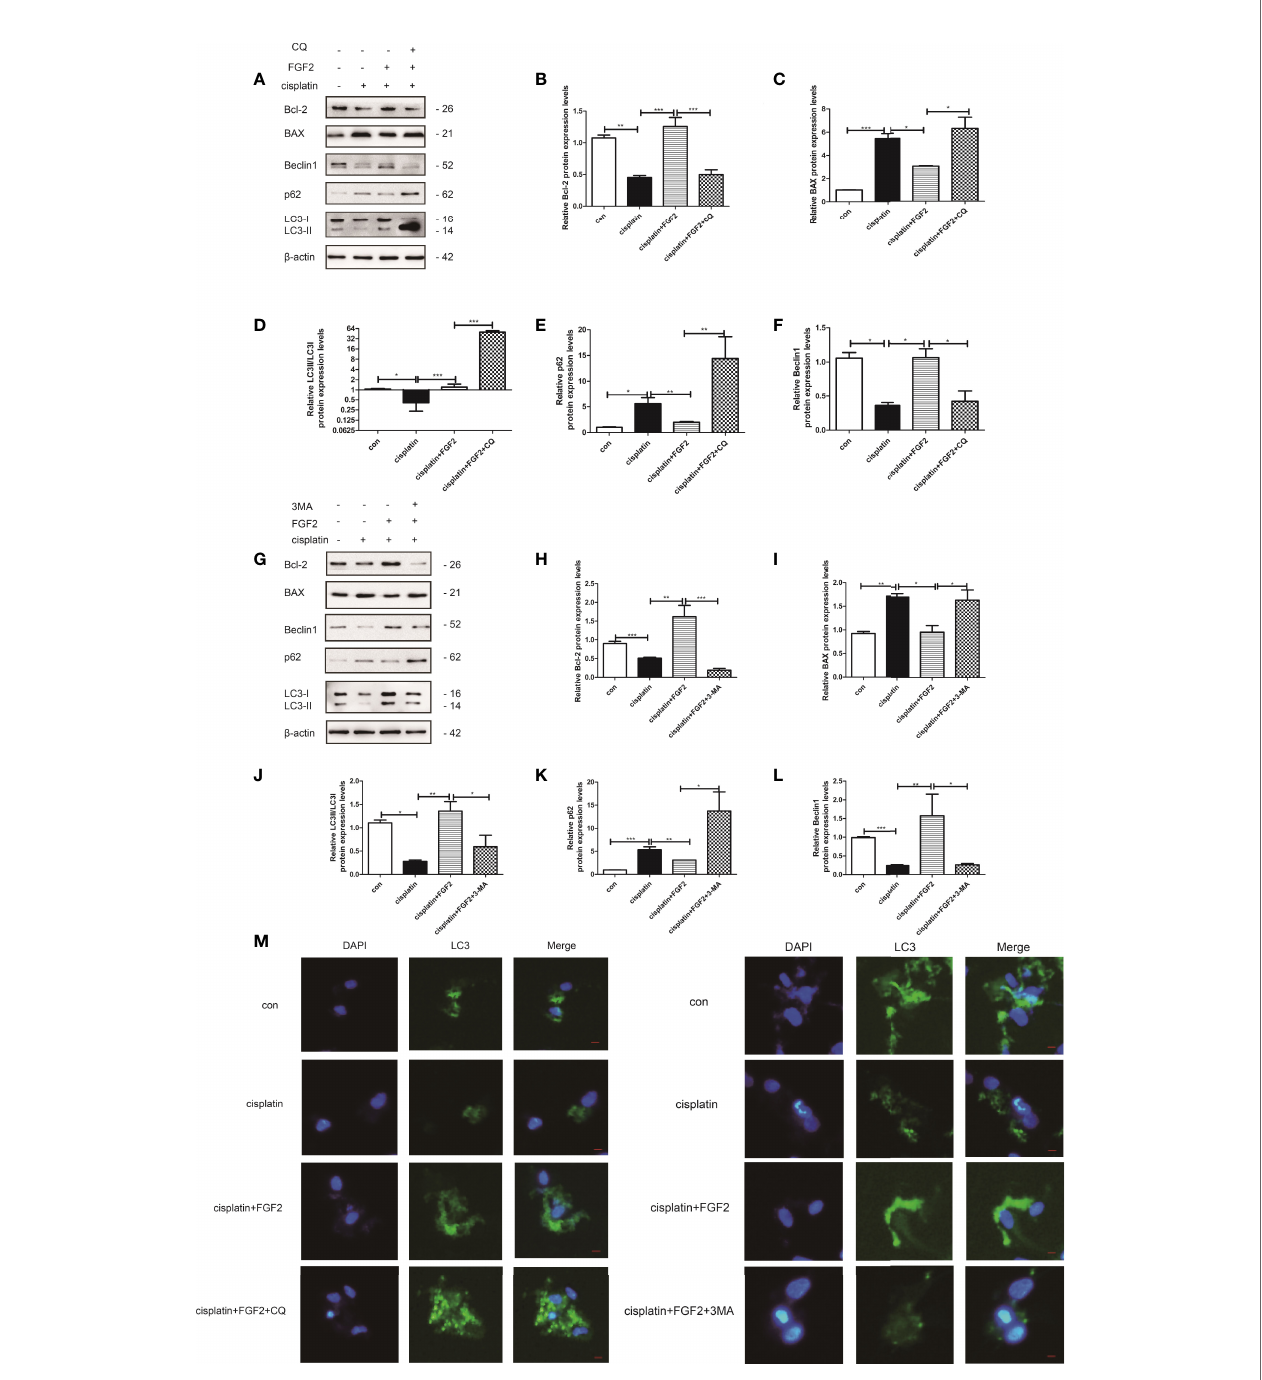
FIGURE 3 | Inhibition of autophagy by 3-MA and CQ attenuated the protective effects of FGF2 on injured KGN cells. (A) The injured KGN cells were treated with FGF2 (25 ng/ml) for 72 h and incubated with 3-MA (10 mM) for another 24 h. The expression of Bcl-2, BAX, LC-3, Beclin1, and p62 was monitored by Western blot. Here, b -actin was used as a loading control. (B – F) Quantitative comparison of the different expression levels of Bcl-2, BAX, LC3, Beclin1, and p62. One-way ANOVA followed by Tukey ’ s multiple comparison test. The results were shown as mean ± SEM from three independent experiments ( a = 0.05, * P < 0.05, ** P < 0.01, *** P < 0.001). (G) The injured KGN cells were treated with FGF2 (25 ng/ml) for 72 h and incubated with CQ (50 m M) for another 24 h. The expression of Bcl-2, BAX, LC-3, Beclin1, and p62 was monitored by Western blot. Here, b -actin was used as a loading control. (H – L) Quantitative comparison of the different expression levels of Bcl-2, BAX, LC3, Beclin1, and p62. One-way ANOVA followed by Tukey ’ s multiple comparison test. The results were shown as mean ± SEM from three independent experiments ( a = 0.05, * P < 0.05, ** P < 0.01, *** P < 0.001). (M) Representative immuno fl uorescence image of GFP-LC3 puncta in KGN cells with different treatments (scale bar: 20 m